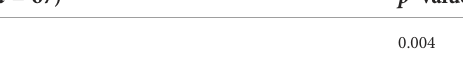
TABLE 2 Mean (SD) age in years at T0 per randomization groups receiving active prophylactic treatment (A, OM – 85/placebo and C, OM – 85) or placebo (B) of all patients with stool specimens and gut microbiota analysis available ( n = 144). All OM – 85 (A + C) ( n = 77)